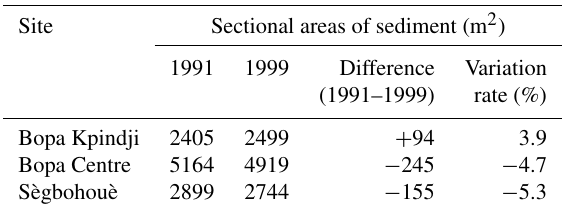
Table 1. Sedimentation evolution in some parts of the Ahémé lake from 1991 to 1999.